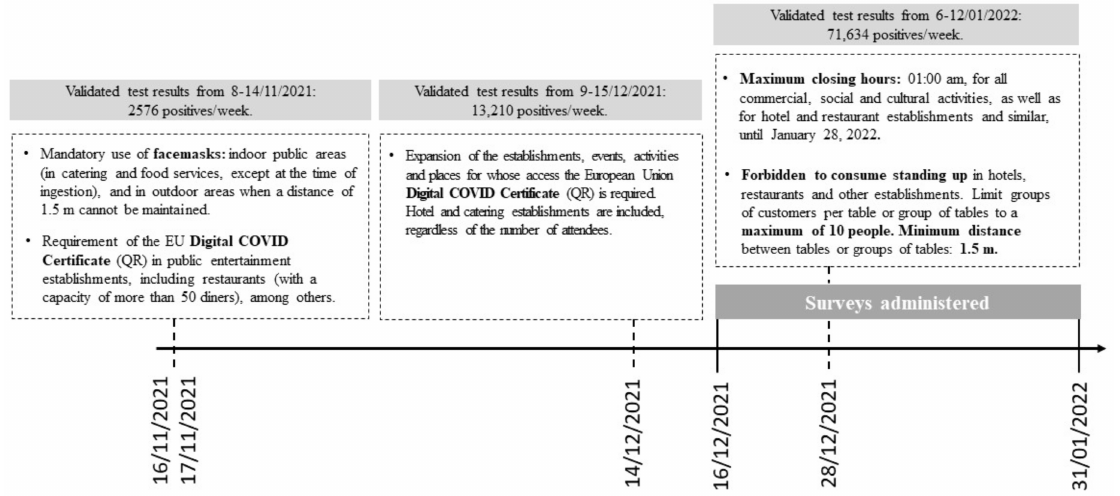
Figure 1. Survey collection timeline, epidemiological situation, and Basque Country mandates in response to the COVID-19 pandemic (information sources: Servicio Web del Departamento de Salud de Gobierno Vasco (Web service of the Health Department of the Basque Government). Transparencia sobre el Nuevo coronavirus (COVID-19): Datos COVID-19 en Euskadi (Transparency on the new coronavirus [COVID-19]: Data in the Basque Country). https://www.euskadi.eus/boletin-de-datos- sobre-la-evolucion-del-coronavirus/web01-a2korona/es/ (accessed on 1 February 2022); Servicio Web del Departamento de Salud de Gobierno Vasco (Web service of the Health Department of the Basque Government). Transparencia sobre el Nuevo coronavirus (COVID-19): Ú ltimas medidas adoptadas en Euskadi (Transparency on the new coronavirus [COVID-19]: The latest measures adopted in Euskadi). https://www.euskadi.eus/normativa-de-medidas-excepcionales-adoptadas- por-el-nuevo-coronavirus-covid-19/web01-a2korona/es/ (accessed on 1 February